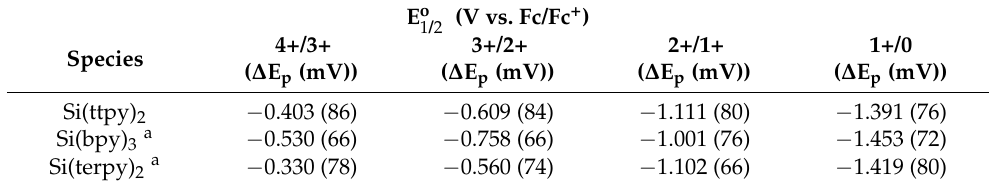
Figure 1. ( top ) Cyclic voltammogram of 1.0 mM [Si(ttpy) 2 ](PF 6 ) 4 in acetonitrile with 0.100 M TBAPF 6 , with a platinum disk working electrode. Scan rate = 0.200 V/s with iR compensation. ( bottom ) Mole fraction of each charge state as a function of applied potential calculated from observed reduction potentials at 25 °C. Table 1. Reduction potentials for [Si(ttpy) 2 ](PF 6 ) 4 , [Si(terpy) 2 ](PF 6 ) 4 , and [Si(bpy) 3 ](PF 6 ) 4